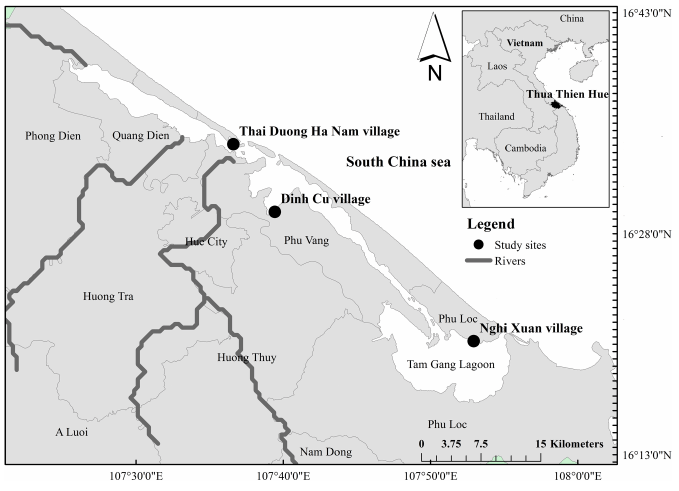
Fig. 1 . The study sites in the Tam Giang